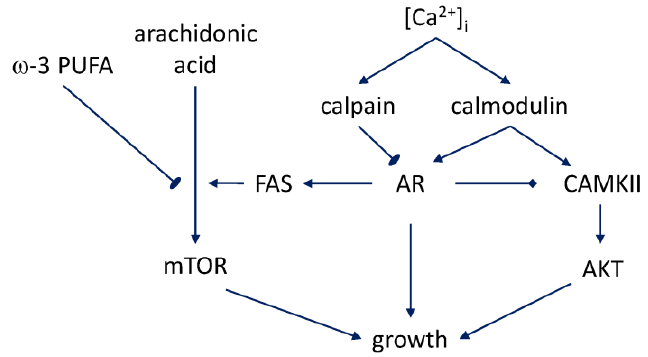
Figure 1. Some of the pathways involved in the emergence of androgen-independent growth.